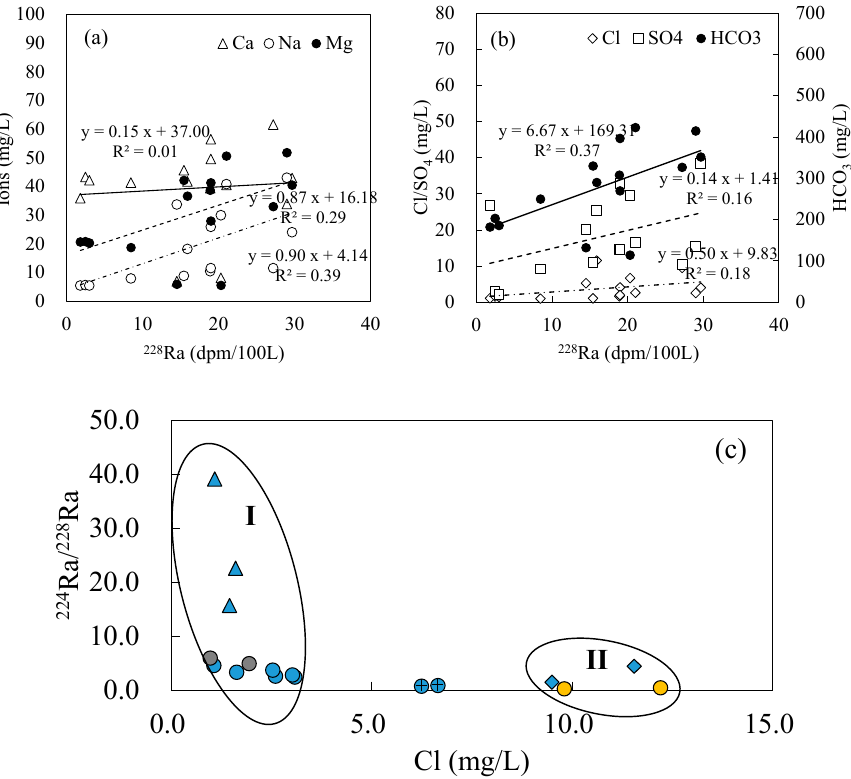
Figure 9. Relationship between ( a ) Na, Ca and 228 Ra, ( b ) Cl, SO 4 and 228 Ra, and ( c ) 224 Ra / 228 Ra and Cl. Triangles are river samples, circles are groundwater samples, and circles with a cross are the water samples at the borehole ZK. Yellow represents the spring at Zhanggu, grey represents the spring Kemu, diamonds are samples at Weishengyuan and Ganengou, and blue represents the rest.